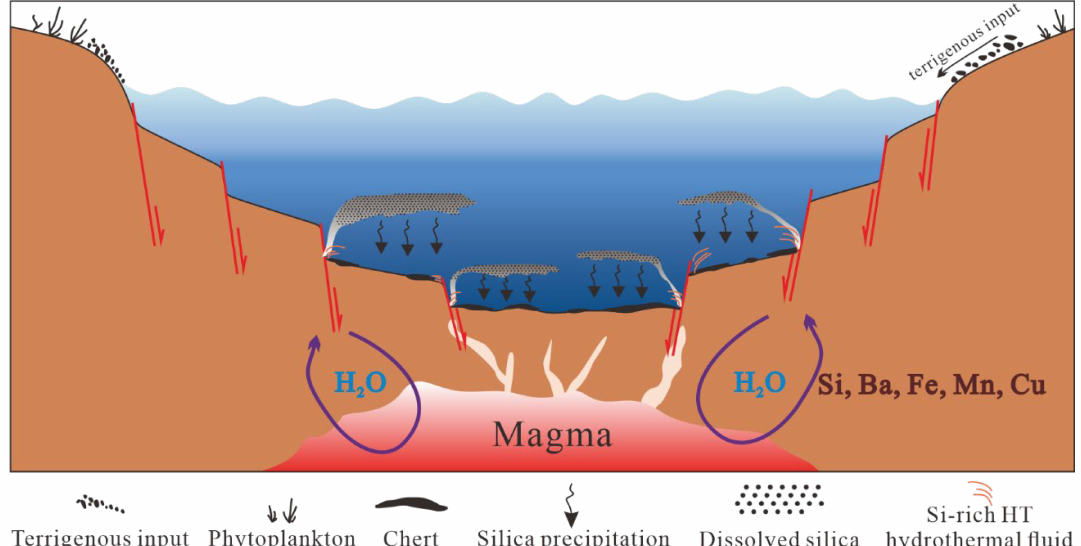
Figure 10. Schematic diagrams showing the silica precipitation model of chert nodules in the Lucaogou Formation from the Junggar Basin, NW